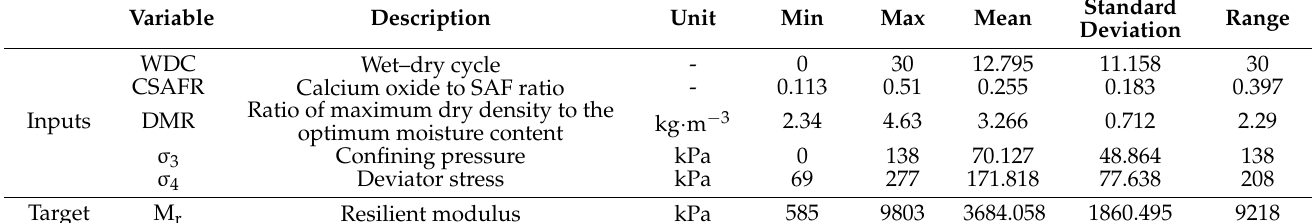
Table 1. Description of input and target parameters for model development.